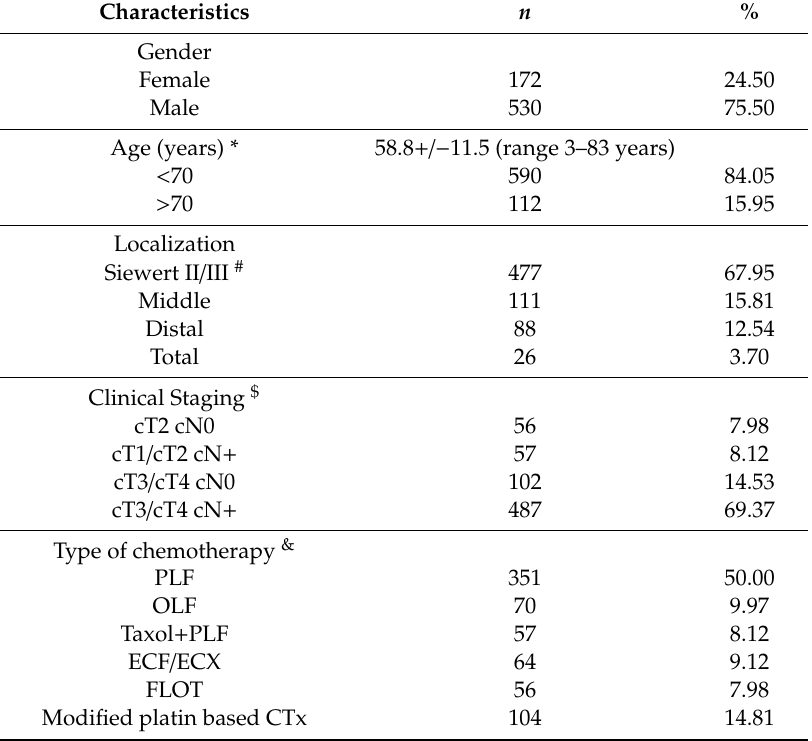
Table 1. Baseline